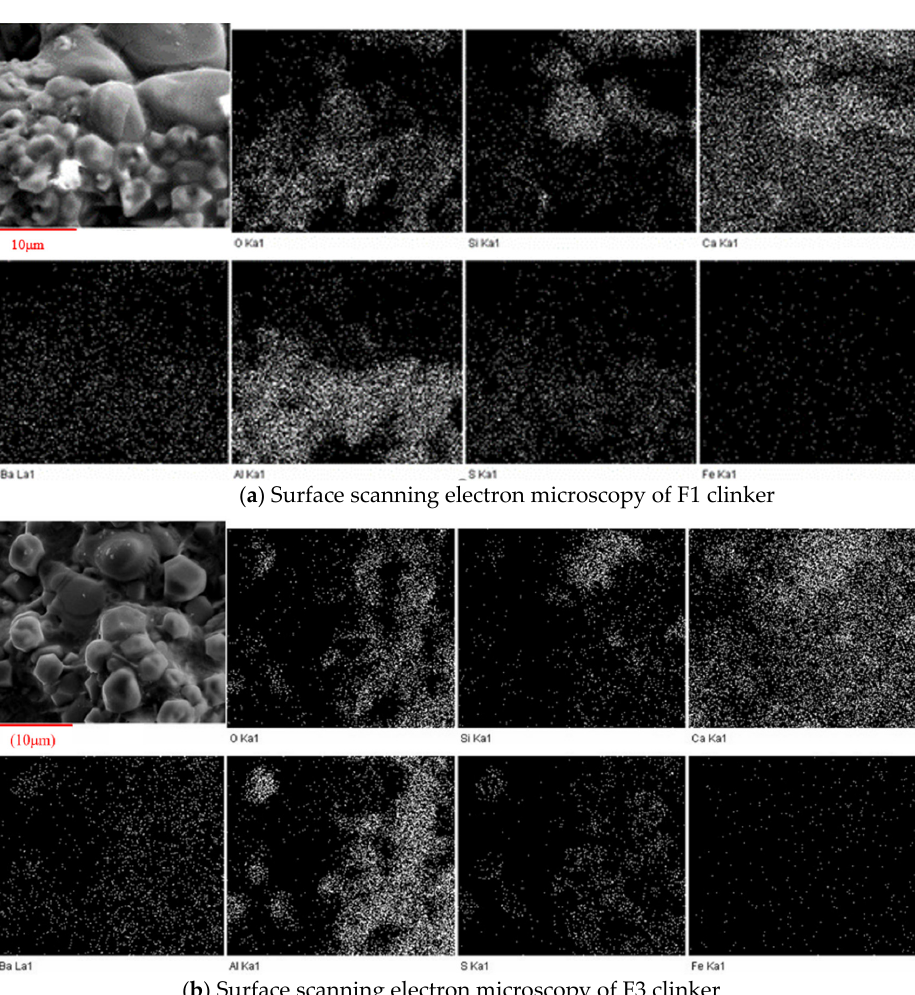
Figure 9. Surface scanning electron microscopy of clinkers.